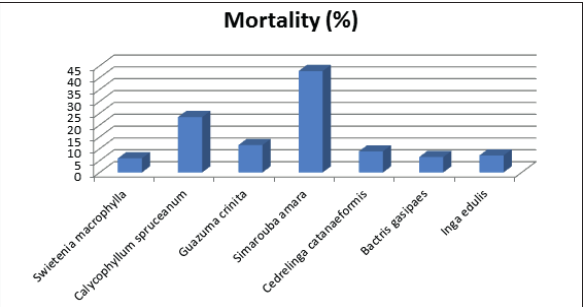
Figure 8. Average percentage of mortality of trees planted for each species in the three farmer’s sites in Santo Tomas, Yurimaguas.